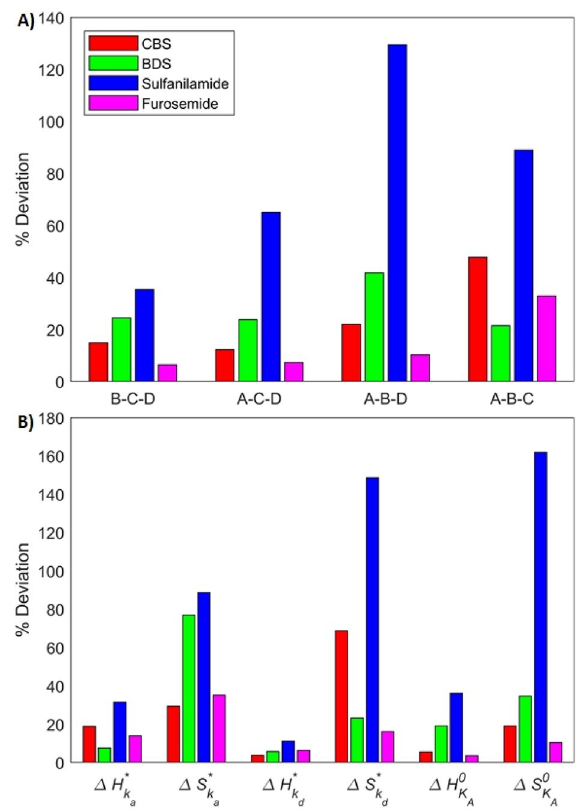
Figure 6. Average deviation between the thermodynamic parameters ( (cid:31) H ∗ k (cid:31) S 0 K A ) derived from single-analyte experiments and parameters derived by fitting the multi-analyte model at four temperatures with any combination of three mixtures ( A – D ). ( A ) Average deviation computed over all parameters for all analytes in all fits. ( B ) Average deviation computed over all fits for all parameters of all